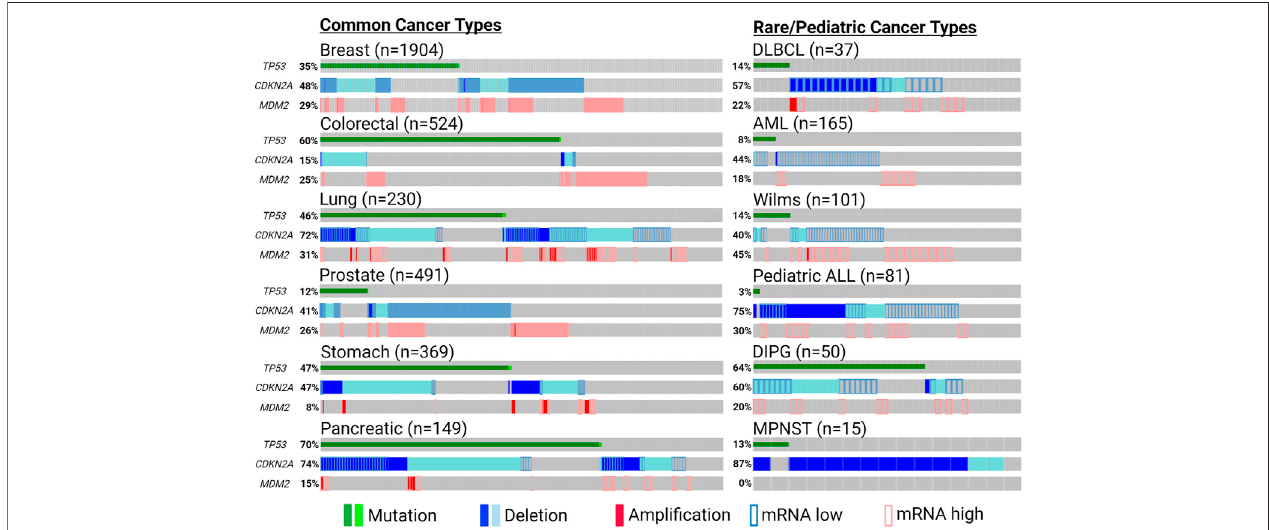
FIGURE 5 | Signi fi cant genetic alterations of p53, MDM2 and ARF in cancers. Tumor-promoting genetic events of TP53 (non-synonymous mutation), MDM2 (ampli fi cation or induced mRNA expression) and CDKN2A (deletion or reduced mRNA expression) are summarized using publicly available patient data from cBioPortal (cbioportal.org) and pediatric cBioPortal (pedcbioportal.org). Percentages shown indicate accumulated fraction of patient samples with highlighted genetic alterations. Thesourcesofthedatapresentedarethefollowing:Breast — METABRIC;Colorectal/DLBCL(diffuselargebcelllymphoma)/AML(acutemyeloidleukemia) — TCGA PanCancer; Lung/Prostate/Stomach/Pancreatic — TCGA Firehose; DIPG (diffuse intrinsic pontine glioma) — PNOC; Wilms/pediatric ALL (acute lymphoblastic leukemia) — TARGET; MPNST (malignant peripheral nerve sheath tumor) — MSKCC. Expression of mRNA levels (except for MPNST) are shown based on expression z-scores relative to all available diploid samples ( < − 0.5: mRNA low; > 0.5: mRNA high). Created with BioRender.com.